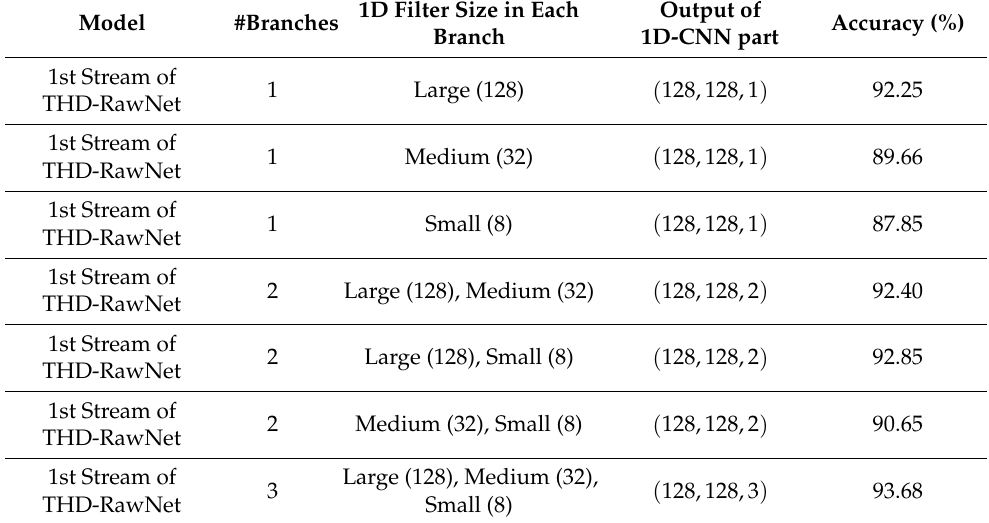
Table 4. Performance of the first stream of THD-RawNet with different configurations.